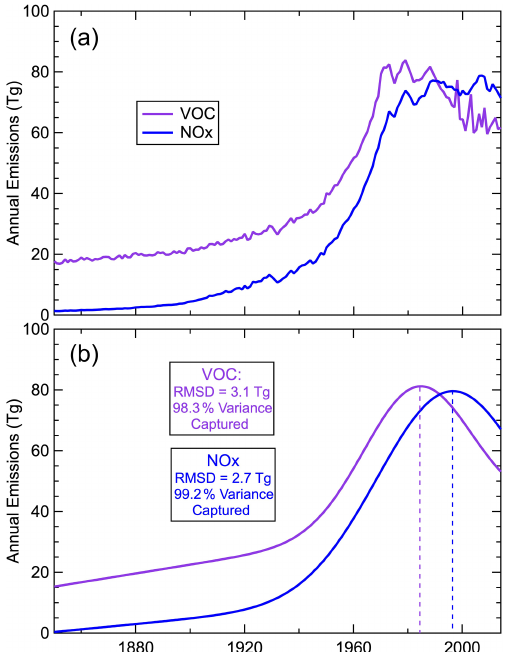
Figure 7. Ozone precursor emissions from anthropogenic and biomass burning sources, which are common in all six CMIP6 ESMs, integrated over northern midlatitudes. (a) Annual emissions and (b) fits of Eq. (9) to those emissions with fit statistics annotated. Vertical dashed lines indicate the year of the maximum emissions ( m em parameter), as in Figs. 5 and